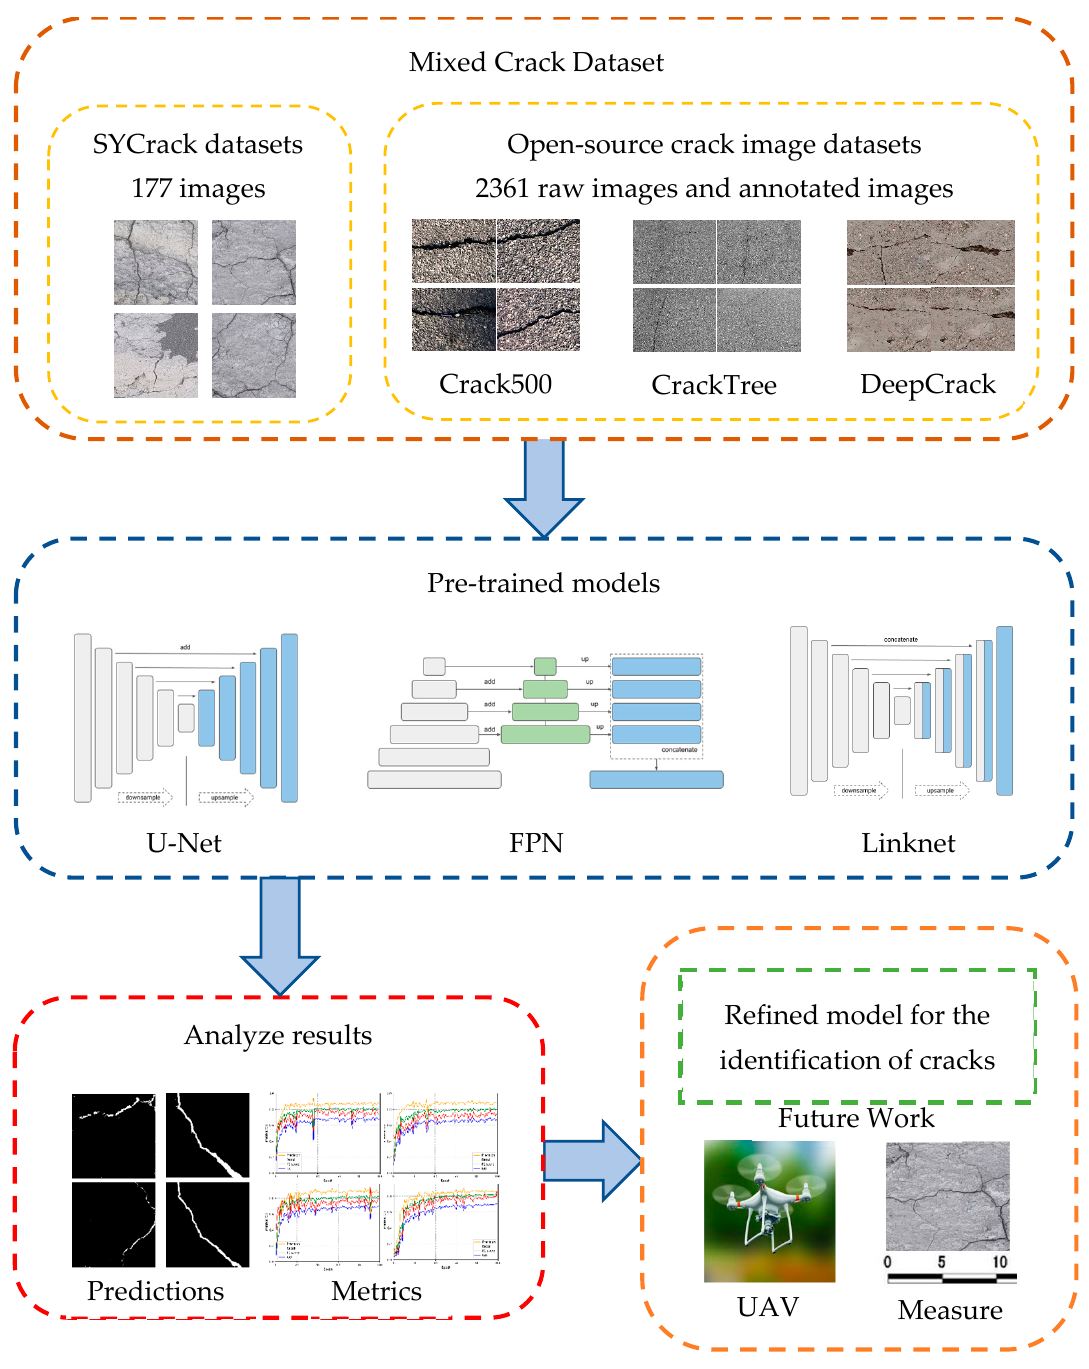
Figure 2. Workflow of the proposed method for detecting and predicting cracks in rammed earthen heritage